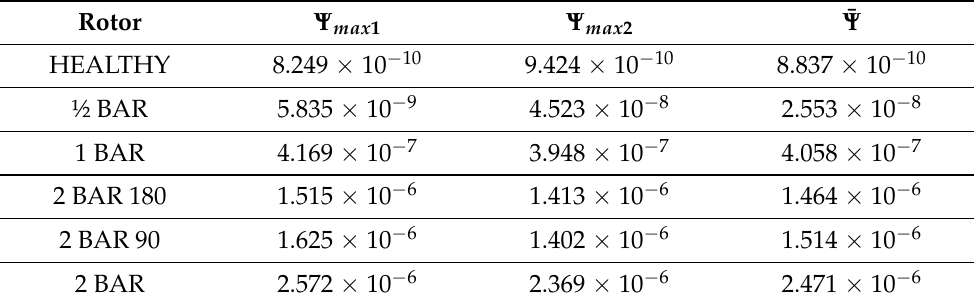
Table 2. Teager energy maximums at f 0 = 30 Hz.